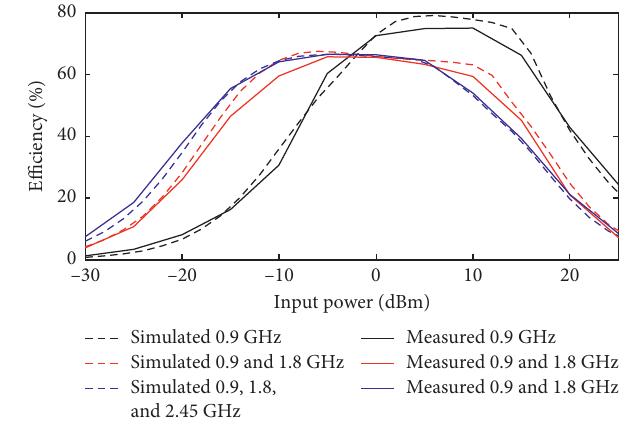
Figure 13: Simulated and measured efficiency of the rectifier vs. input power level at frequencies of interest.